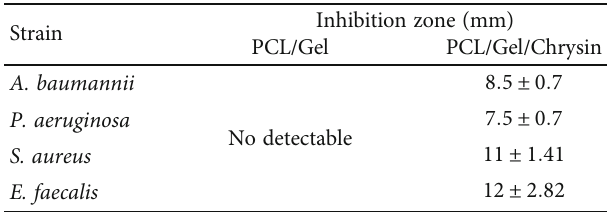
Table 1: Inhibition zone (mm) of PCL/Gel with and without